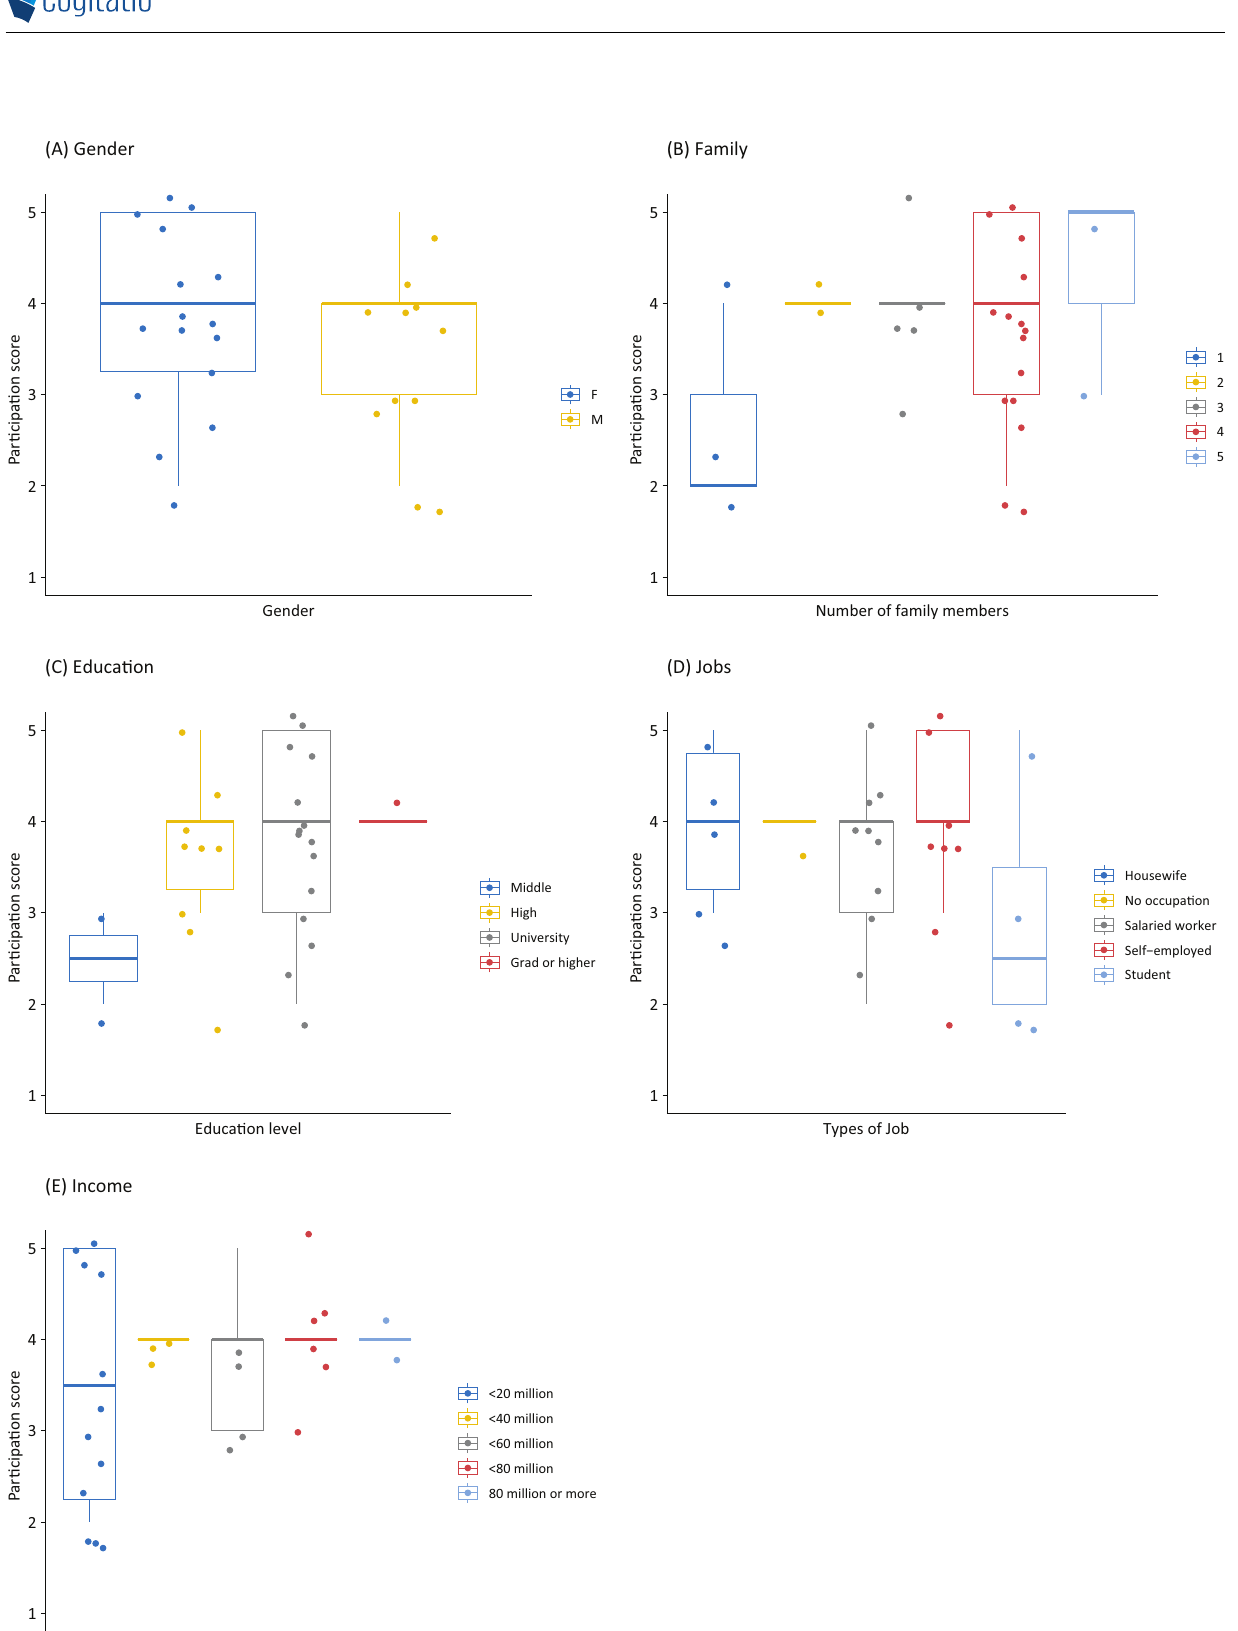
Urban Planning, 2023, Volume 8, Issue 2, Pages